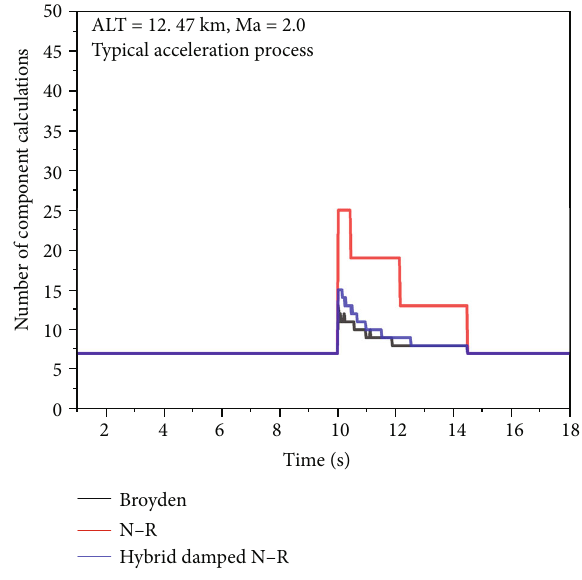
Figure 8: The variation pattern of the number of component calculations during the acceleration